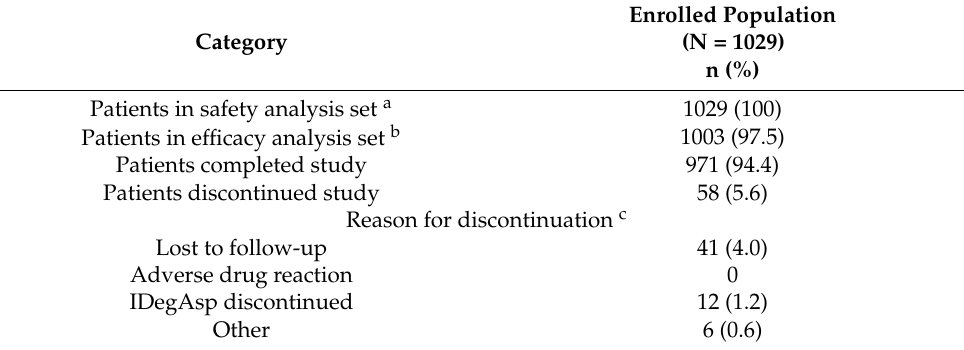
Table 1. Summary of patient